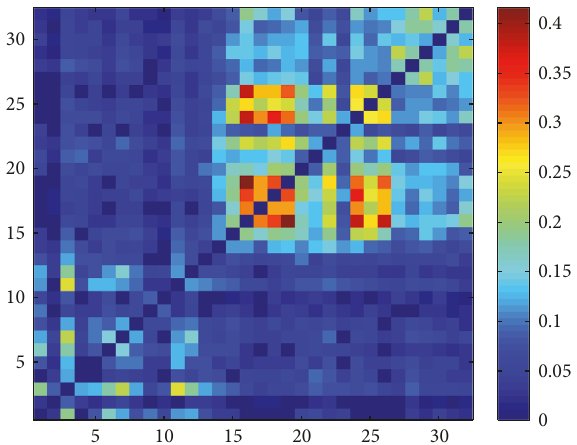
Figure 3: The color map of the contagion distribution for the entire crisis